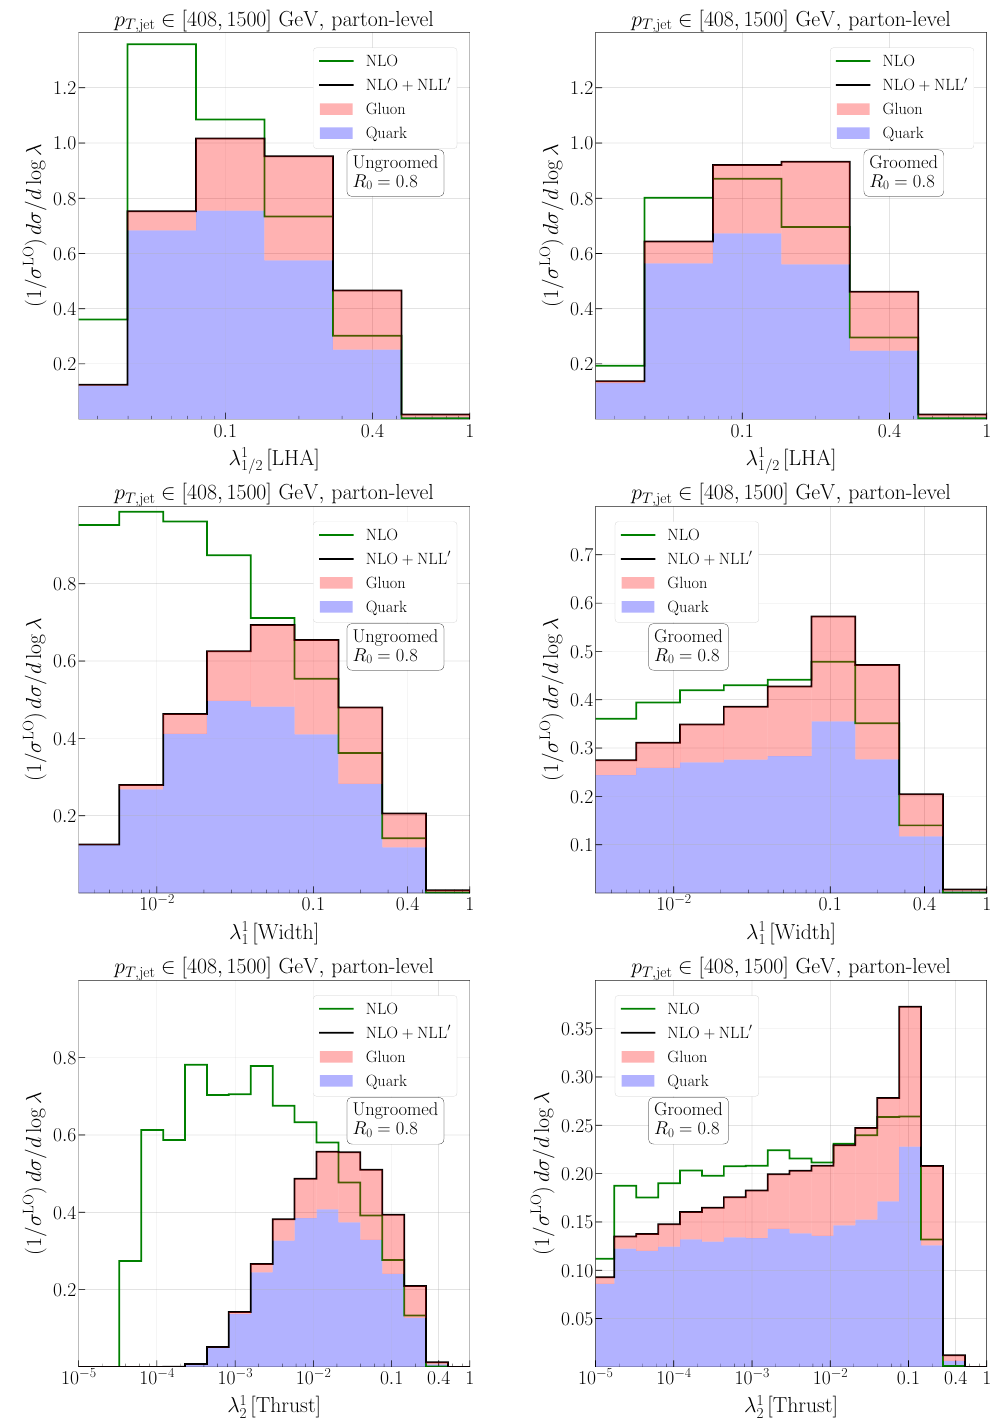
Figure 9 . Fixed-order and matched predictions at NLO and NLO + NLL 0 accuracy, for ungroomed (left row) and groomed (right row) angularities, for α ∈ { 1 / 2 , 1 , 2 } . The colour scheme indicates how the gluon (red) and quark (blue) channel as identified with the BSZ algorithm stack up to form the NLO + NLL 0 prediction. The jet transverse momentum is constrained to p T, jet ∈ [408 , 1500]